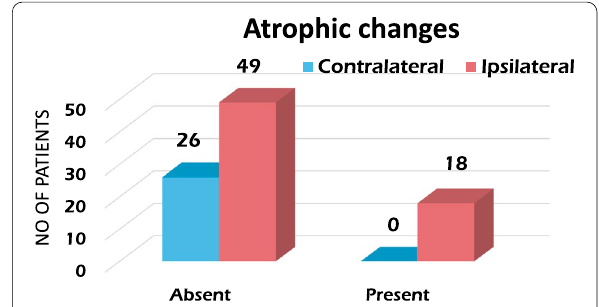
Fig. 4 Bar graph showing the presence of atrophic changes of trigeminal nerve in ipsilateral (symptomatic) and contralateral (asymptomatic) nerves